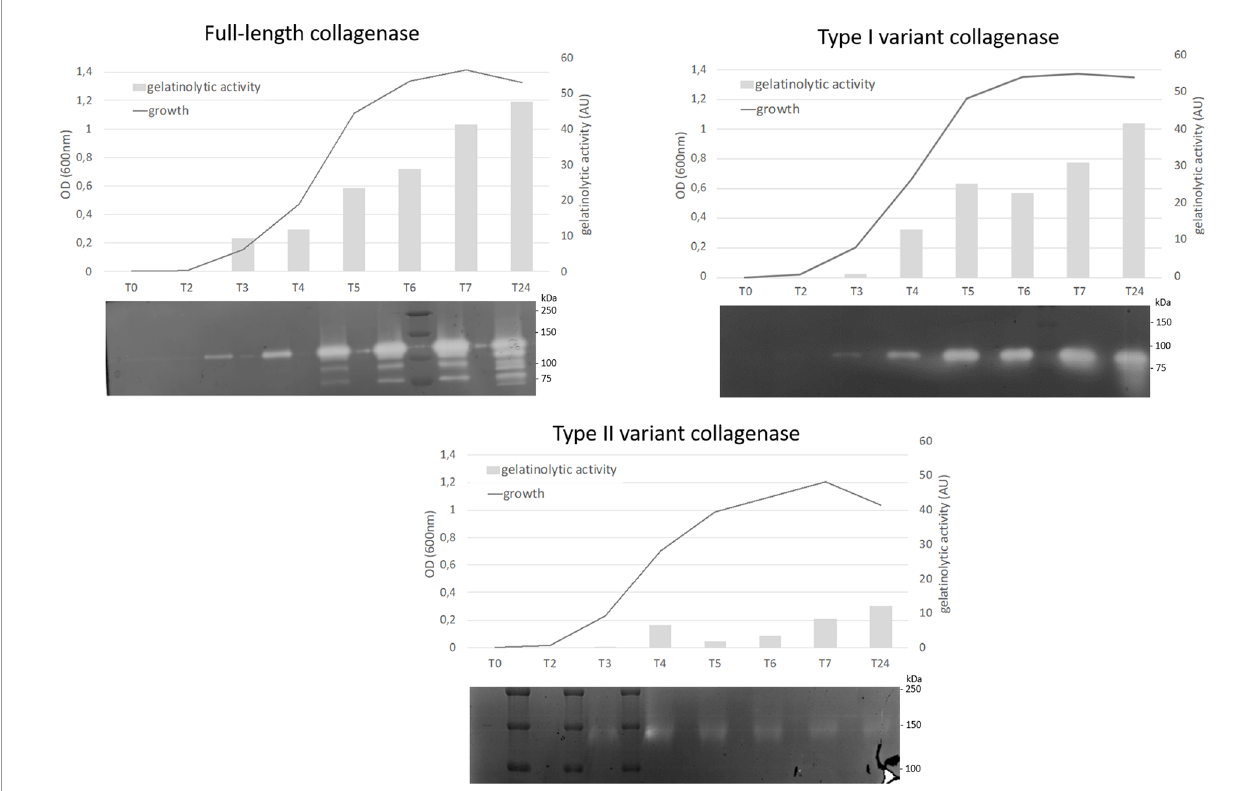
FIGURE 5 | Analysis of proteolytic activity at different stages of growth of C. perfringens strains encoding for 3 different collagenase types. Growth was analyzed by measuring optical density at 600 nm at 8 timepoints (0, 2, 3, 4, 5, 6, 7 and 24 h post inoculation). At each timepoint supernatant samples were collected and analyzed by zymography. The observed bands were measured by Quantity One to determine the relative gelatinolytic activity. AU = arbitrary units. One representative image per collagenase variant type is shown (full-length collagenase: JIR4857, type I: CP56 and type II: D8).